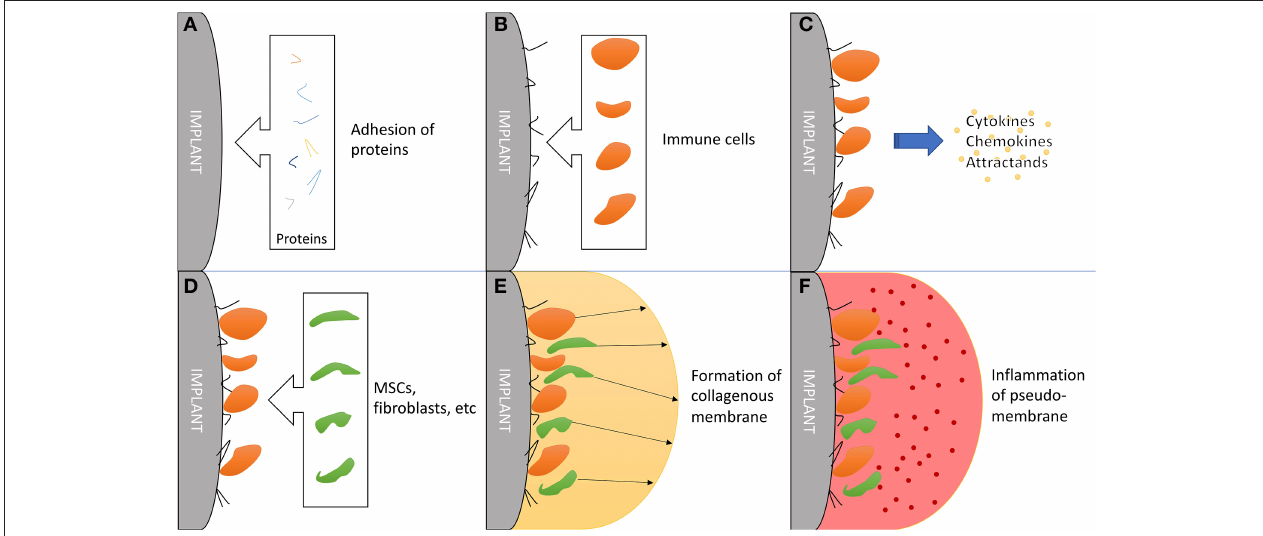
FIGURE 4 | The critical role of the immune system in formation and function of a synovial-like periprosthetic membrane. (A) Adhesion of local proteins to prosthesis surface within minutes of surgery. (B) Attraction of blood cells: macrophages, monocytes and thrombocytes. (C) Secretion of mesenchymal (stem/stromal) cell attractants. (D) Homing of mesenchymal stem/stromal cells and fibroblast. (E) Production of collagen and granulomas to form a synovial-like capsule. This marks the last step in “physiological” prosthesis acceptance. (F) Mechanical instability and wear debris lead to chronic inflammation of the pseudo membrane. Inflammation markers are mainly exhibited by local fibroblasts and